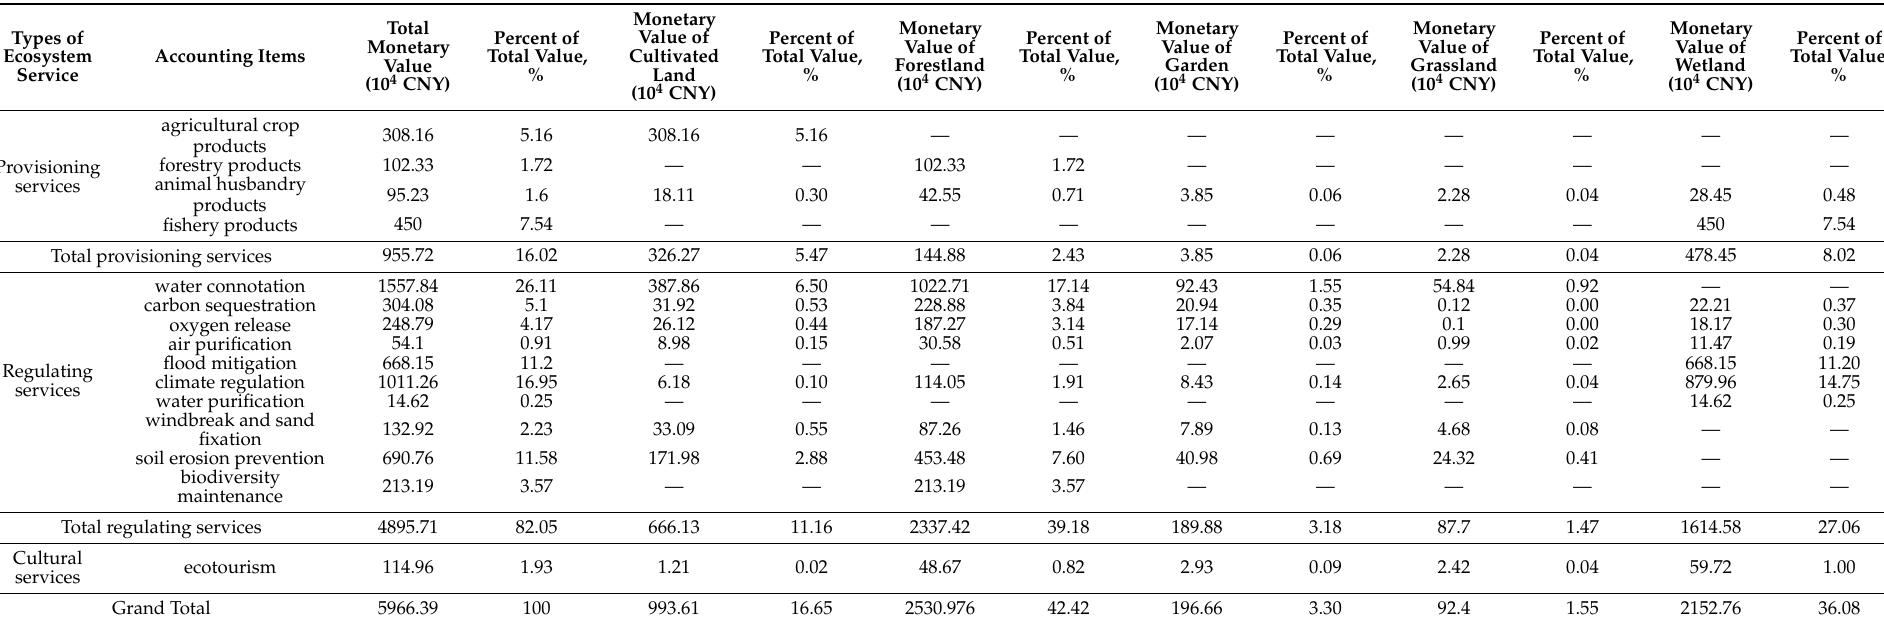
Table 4. GEP and the percent of each ecosystem service item in the grand total monetary value of Nanshi Village in